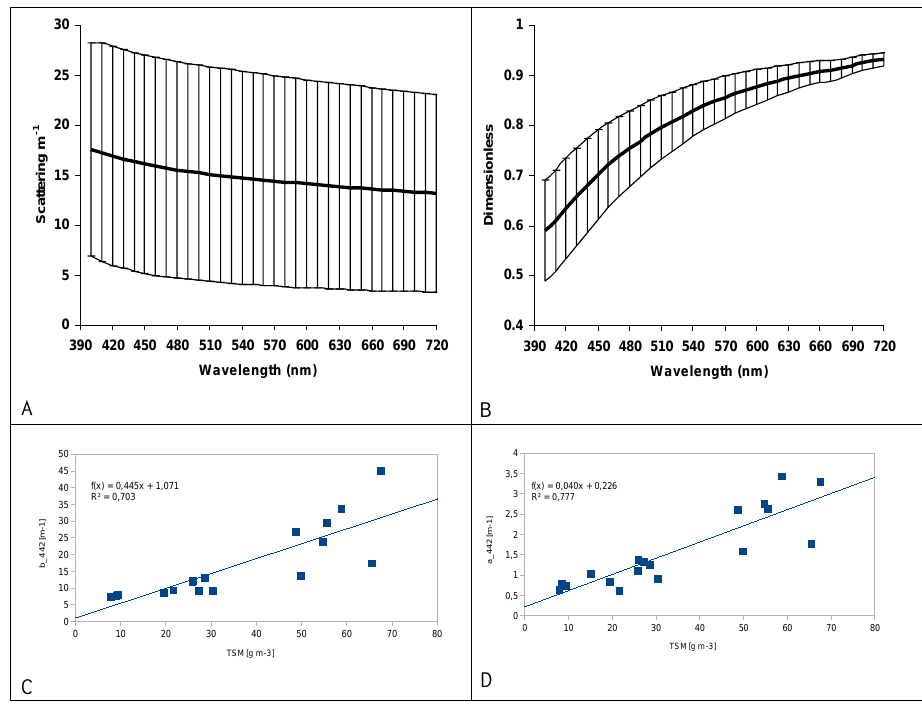
Fig. 9. Means and standard deviations of (A) scattering and (B) the single scatter albedo, as well as the relationship between the total suspended matter concentrations and (C) scattering and (D) absorption